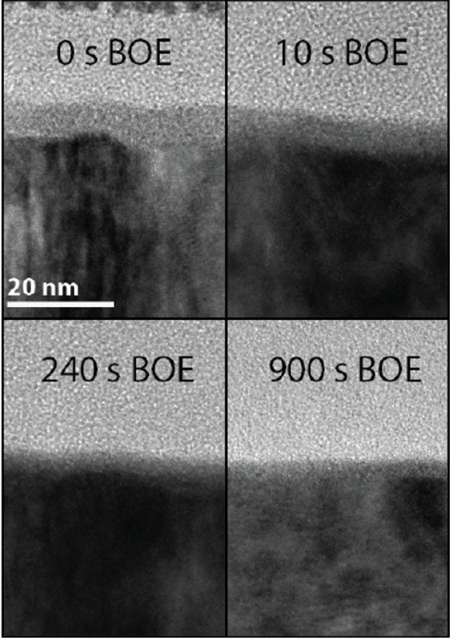
FIG. 15. STEM-EDS cross-section maps of a chip etched for 10 min in 5:1 BOE. Note the reduced oxide thickness at the MA and SA interfaces relative to the standard resonator (Fig. 2). The MS interface is again free of C and O.